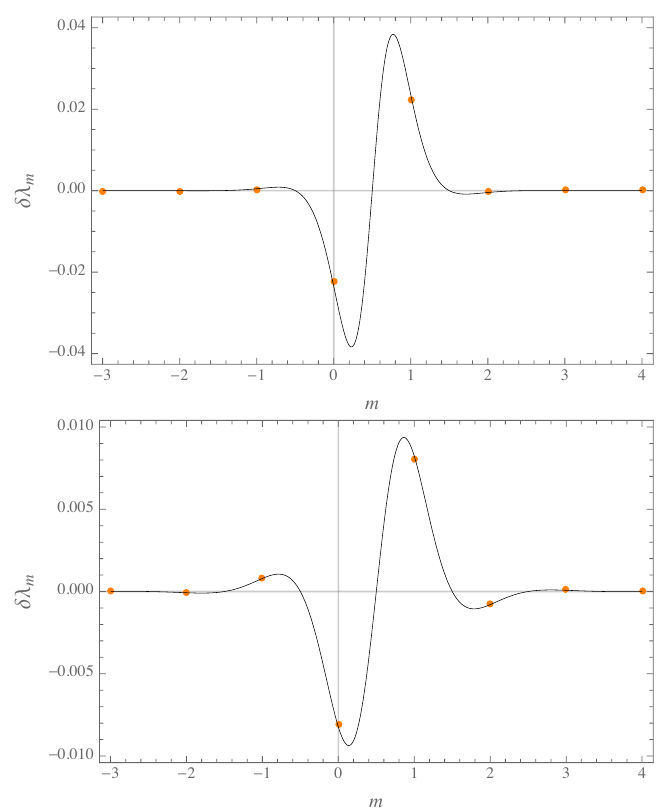
Figure 5 . The difference δλ m between the numerical eigenvalues and the leading order analytics, plotted with the predictions from next order corrections (4.56). The cross-ratio in these figures are x = 0 . 914 (top) and 0 . 9987 (bottom), respectively.